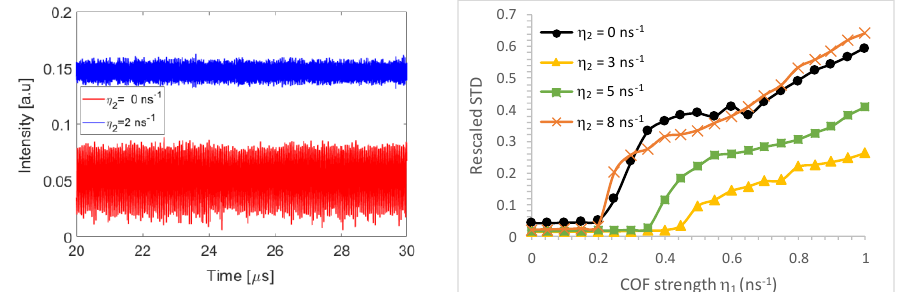
Figure 7. Simulated time traces in the CCW direction when the COF strength is η 1 = 0.4 ns –1 without FOF in red and with FOF using η 2 = 2 ns –1 in blue (left). Standard deviation of the simulated time traces of the laser’s output as a function of the COF strength η 1 for different values of the FOF strength η 2 (right).